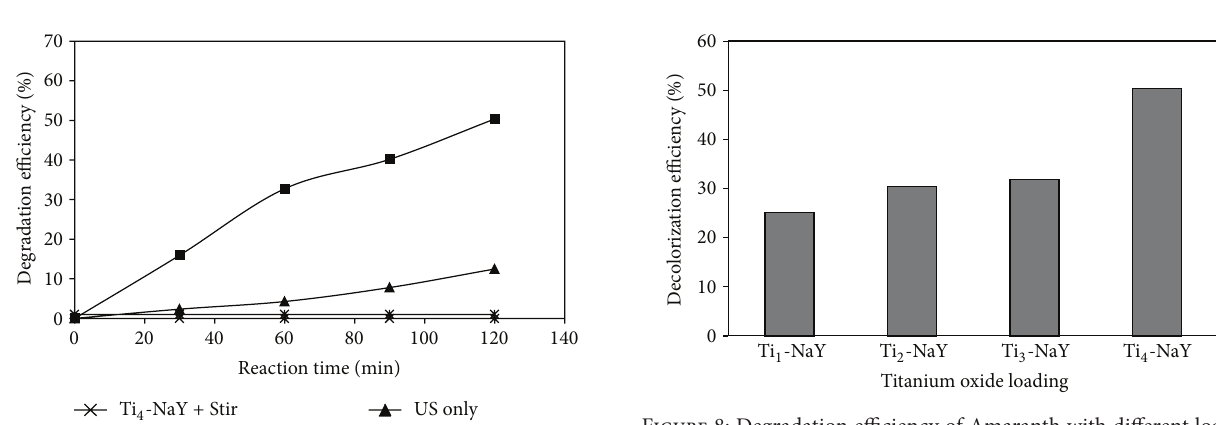
Figure 8: Degradation efficiency of Amaranth with different load- ings of titanium (initial dye concentration 10mg/L, catalyst loading 1.5 g/L, original pH, and 120 min of reaction